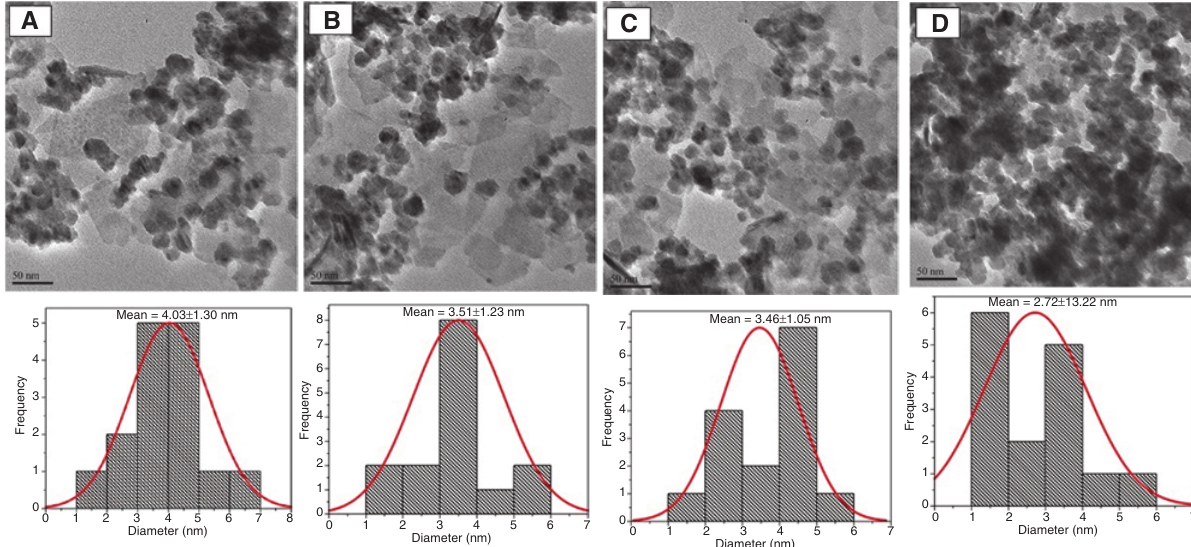
Figure 6: TEM images of blank (A) ZnS nanoparticles capped with (B) 1%, (C) 3%, and (D) 5% PEG.